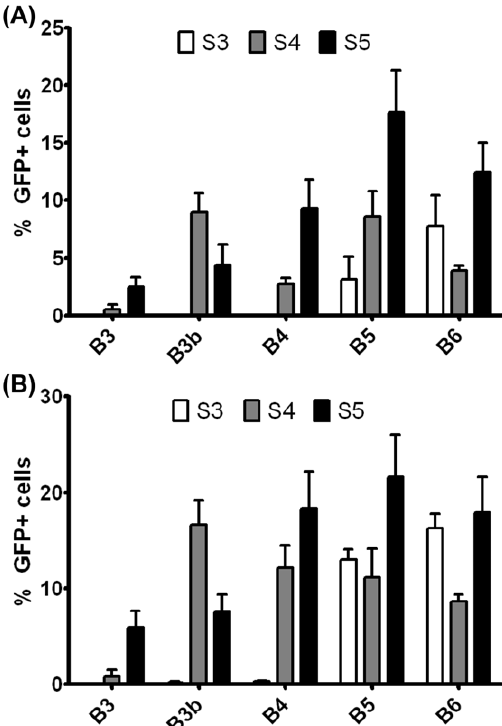
Figure 3. Comparison of base polymer structure with transfec- tion efficacy. Each bar represents the average transfection efficacy associated with the end-modified polymers that contained the base polymer shown (n=11; error bar=SEM). Base diacrylate and side chain amino-alcohols are shown from least hydrophobic to most hydrophobic from left to right. (A) Transfection efficacy of 30 w/w formulations averaged over 11 end-modified amines containing the base polymer shown. (B) Transfection efficacy of 60 w/w formulations averaged over 11 end-modified amines containing the base polymer shown. For statistical analysis, see Table